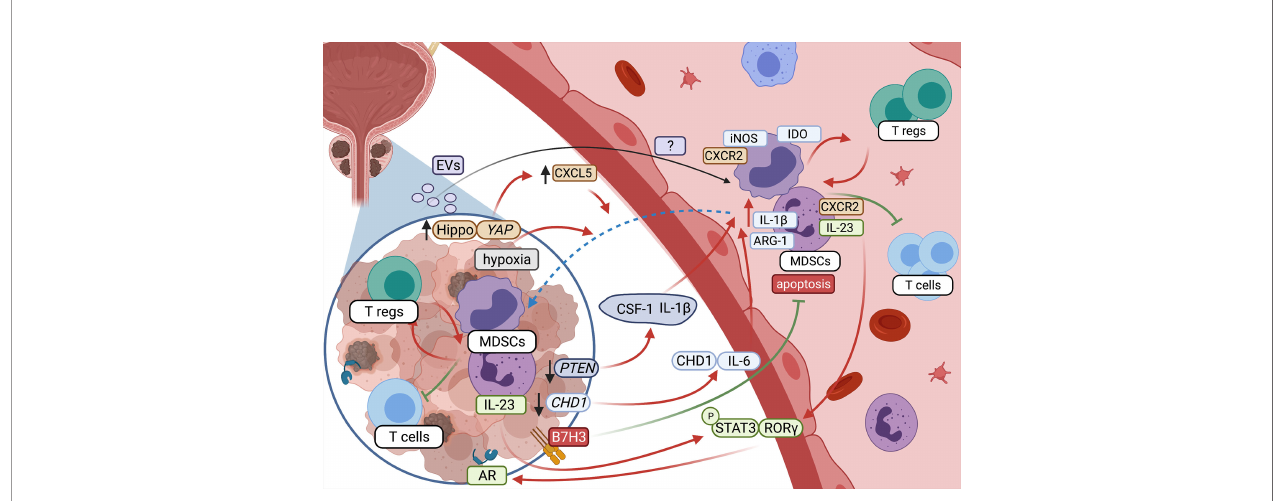
FIGURE 1 | Crosstalk between MDSCs and tumor microenvironment in prostate cancer (created with